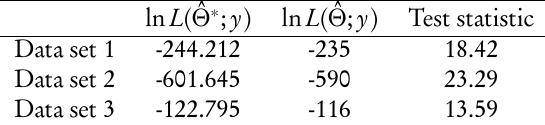
Calculated value of the test statistic in case of generalized likelihood ratio test.